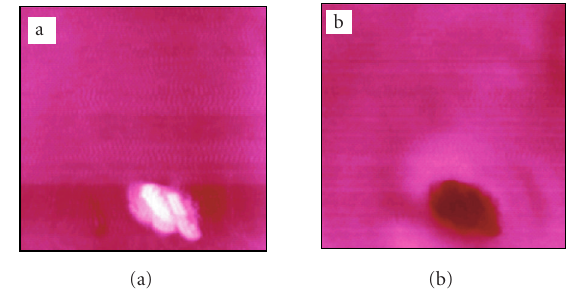
Figure 10: Shear-force AFM (a) (5 μ m, Z range 400nm) and aper- tureless SNOM (b) (488nm) of phthalimide ( 10 ) after 16h in al- most saturated water vapor showing negative contrast at the island where the product 11 resides.